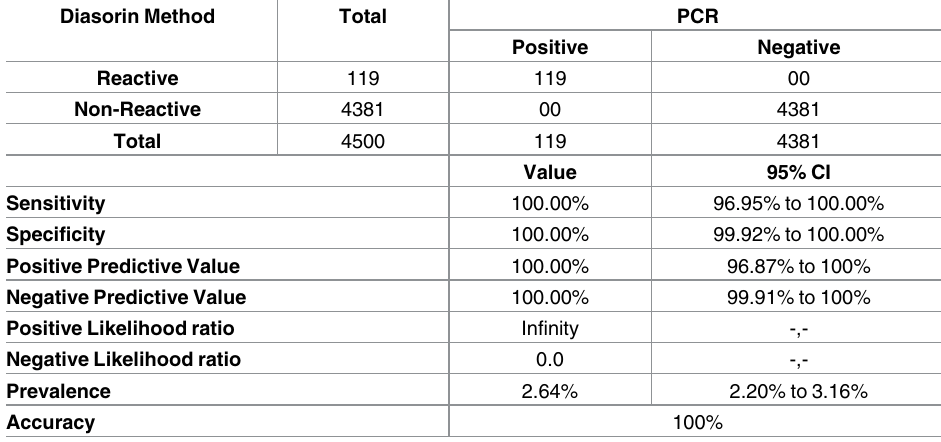
Table 4. Overall results of LIAISON ® XL CLIA Murex Assay (n = 4500).